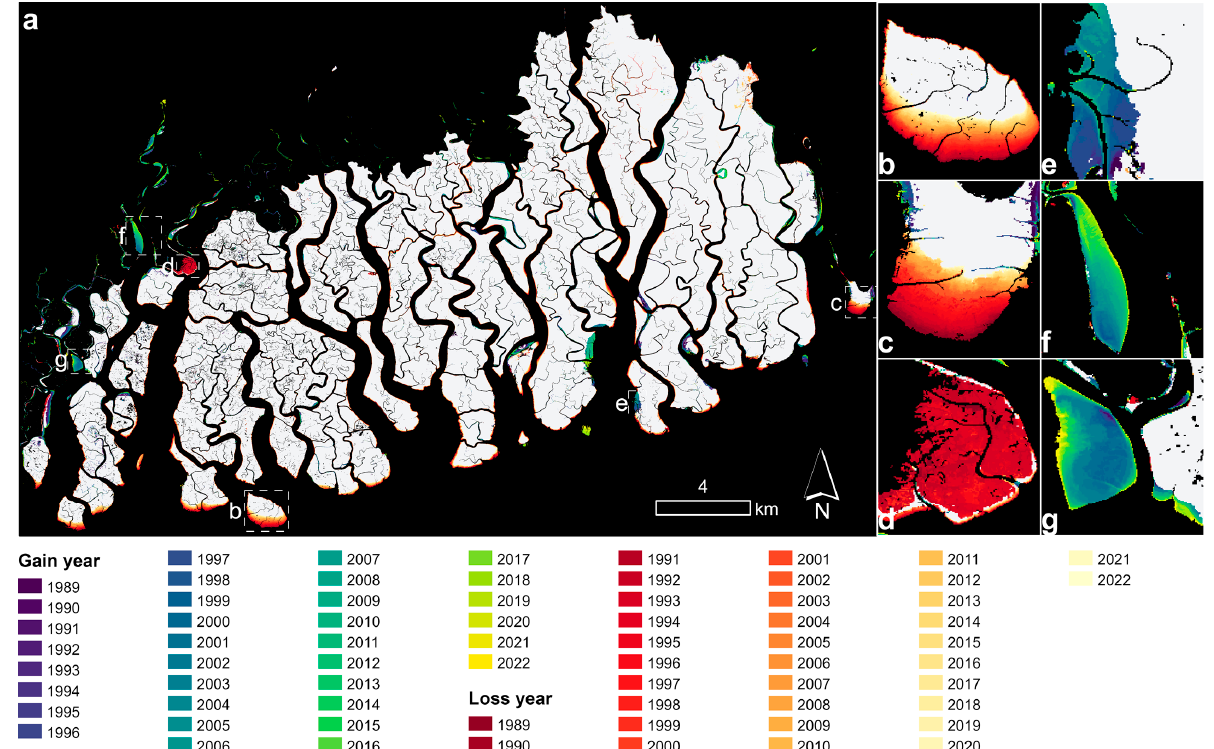
Figure 7. ( a ) Spatial distribution of loss/gain timing in mangrove cover from 1988–2022. Six regional subsets of ( b – d ) losses and ( e – g ) gains show case studies of mangrove change in the Sundarbans.